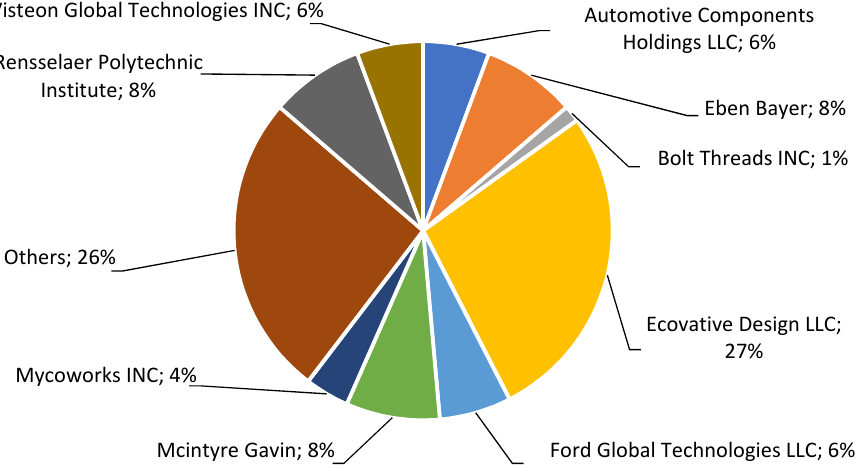
Figure 4. Shares of companies in the total number of patent applications.